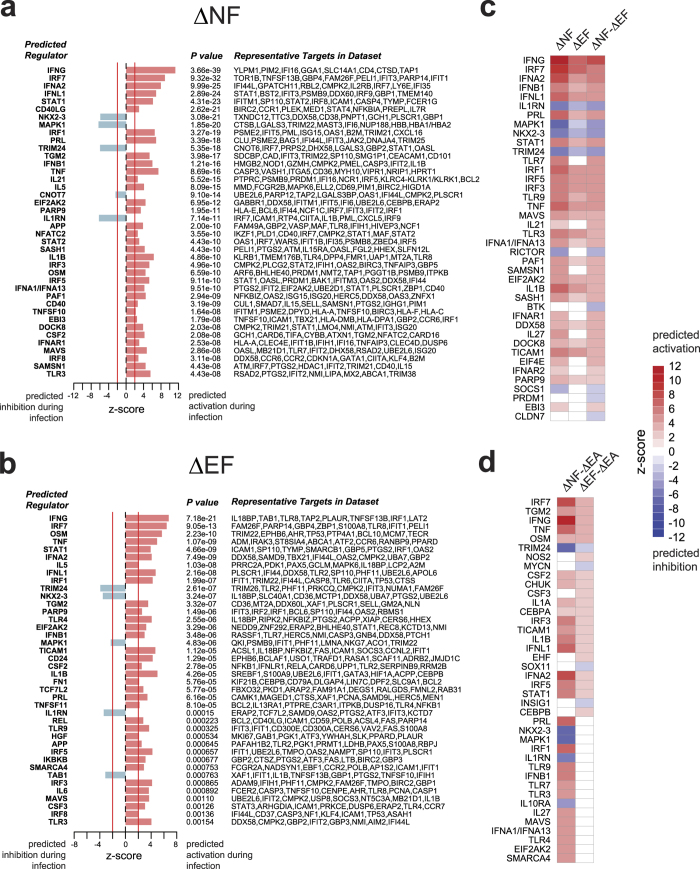
Upstream regulator analysis reveals graded activation of interferon-mediated inflammation.Upstream regulator analysis using the DEGs with FDR <0.05 (no fold-change cut-off) for the ΔNF (a) and ΔEF (b) classes. A positive z-score predicts activation of the indicated gene based on the expression patterns of downstream genes, whereas a negative z-score predicts inhibition. (c) Z-score data from (a,b) in heatmap format is shown with the addition of z-scores from the between group (ΔNF-ΔEF) analysis. Rows are sorted by descending Z-scores in the third column. (d) Z–scores in heatmap format for between-class comparisons of ΔNF and ΔEF with ΔEA using DEGS with FDR < 0.10 (no fold-change cut-off). Rows are sorted by descending Z-scores in the second column. Only the top 40 predicted regulators with an absolute z-score >2 and P value <0.01 are shown.